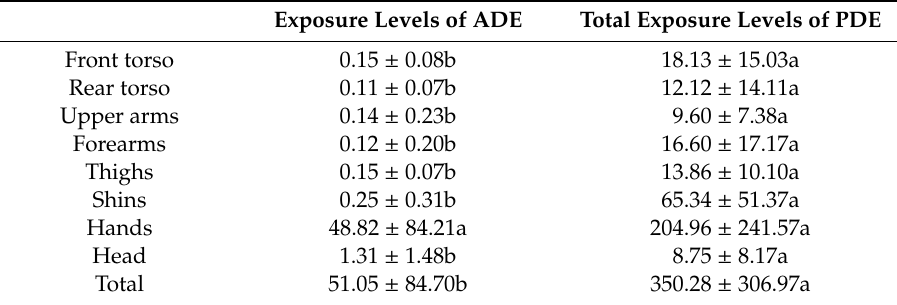
Table 3. Distribution of dermal exposure during application (mg / kg a.i.